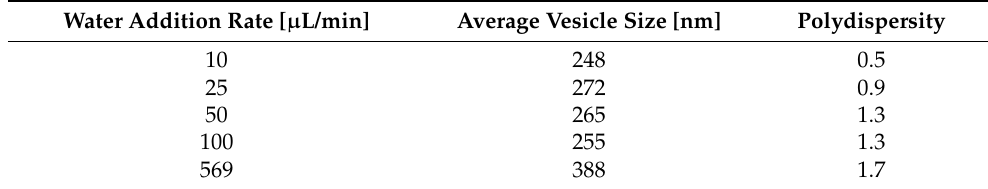
Table 2. Influence of the rate of water addition on the average vesicle size and polydispersity of the polymer vesicles.